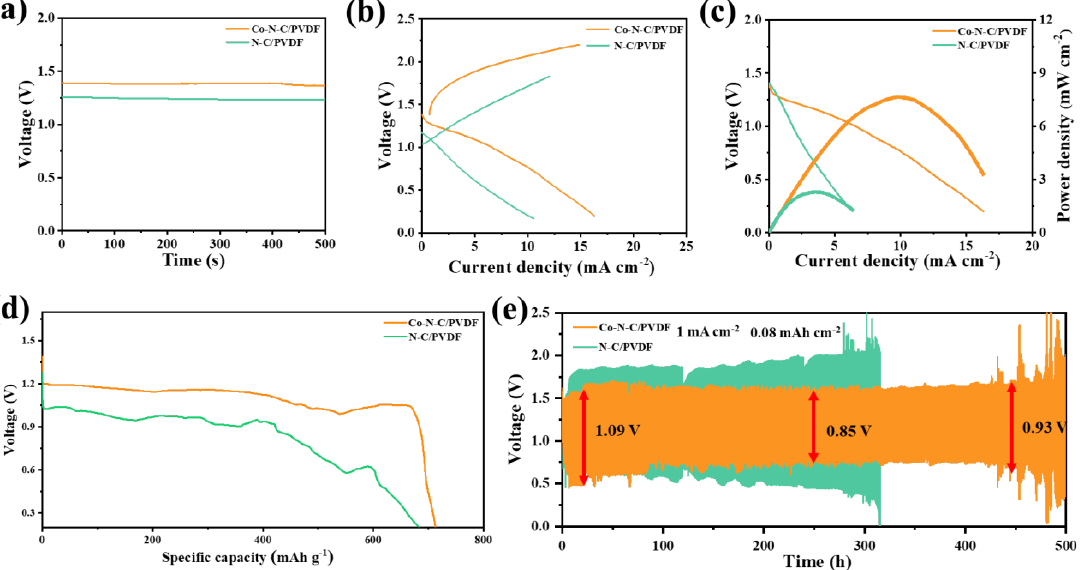
Figure 5. Electrochemical performance of Co−N−C in aqueous Zn–air battery. ( a ) Open−circuit voltage curves. ( b ) Charge−discharge polarization curves;.( c ) Power density curves of the Co−N−C. ( d ) Zn mass−normalized specific capacities. ( e ) Galvanostatic cycling tests at 1 mA cm −2 for Co−N−C.